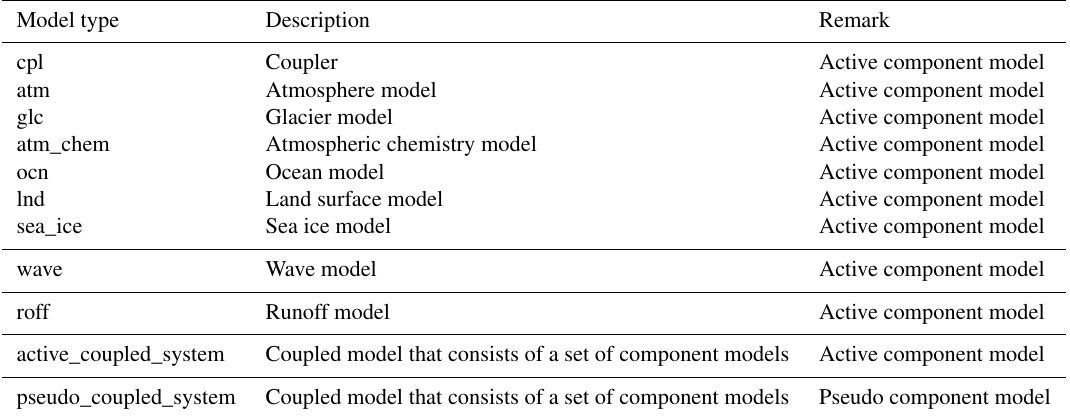
Table 1. Model types currently supported by